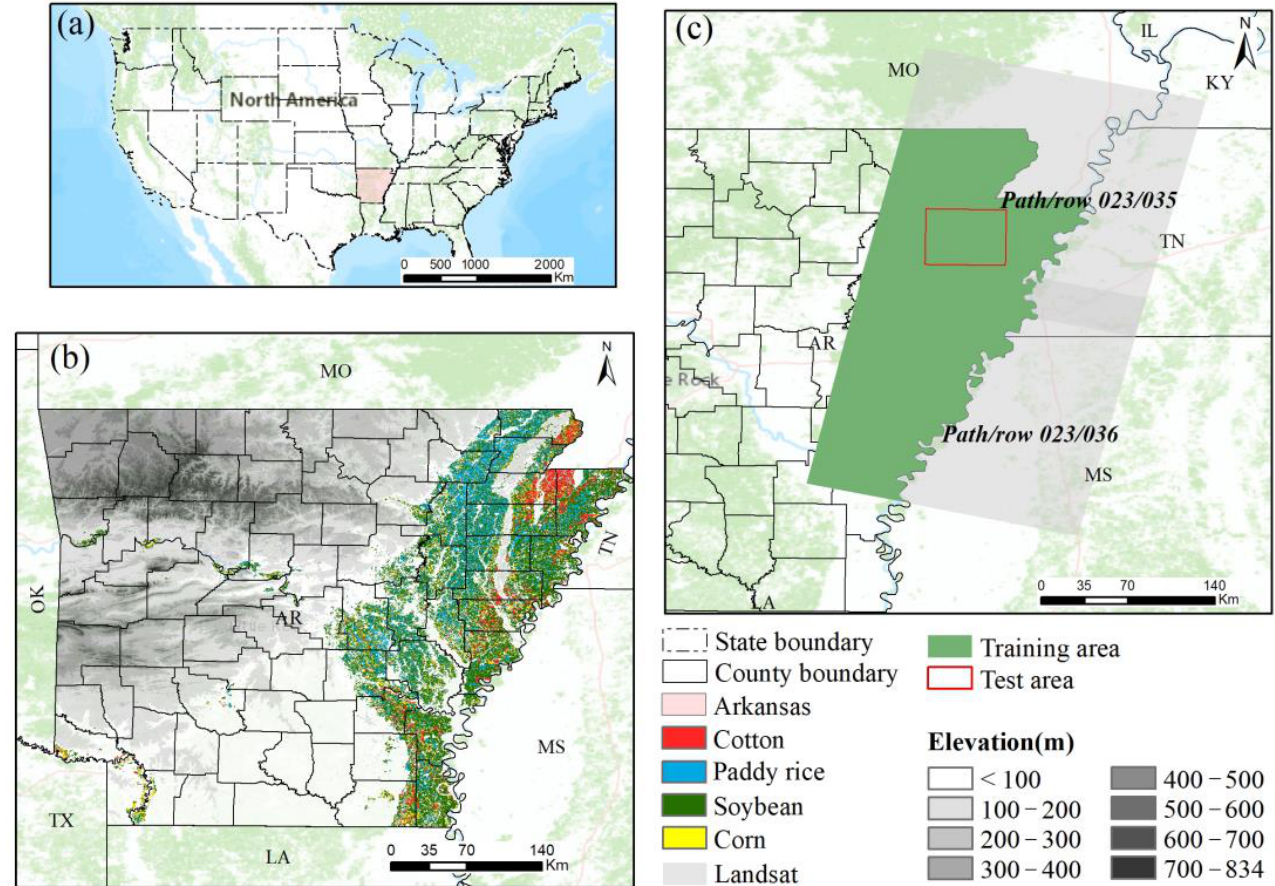
Figure 1. ( a ) Location of Arkansas. ( b ) Crop types of Arkansas in 2018. ( c ) Training and test area. The gray represents the coverage of Landsat image tiles. AR: Arkansas; MO: Missouri; OK: Oklahoma; TX: Texas; LA: Louisiana; MS: Mississippi; TN: Tennessee; KY: Kentucky; IL: Illinois.